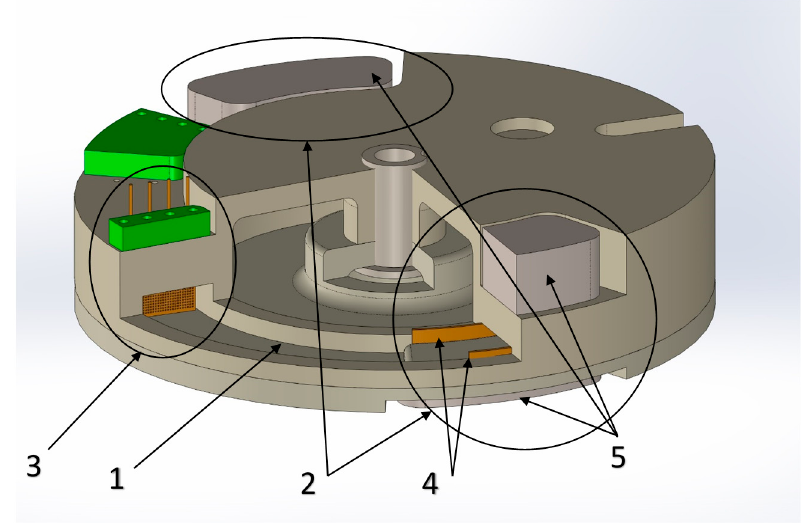
Figure 3. Molecular-electronic angular accelerometer design: 1: toroidal channel; 2: MHD cells; 3: transducer electrode cell; 4: flat MHD electrodes; 5: permanent magnets.